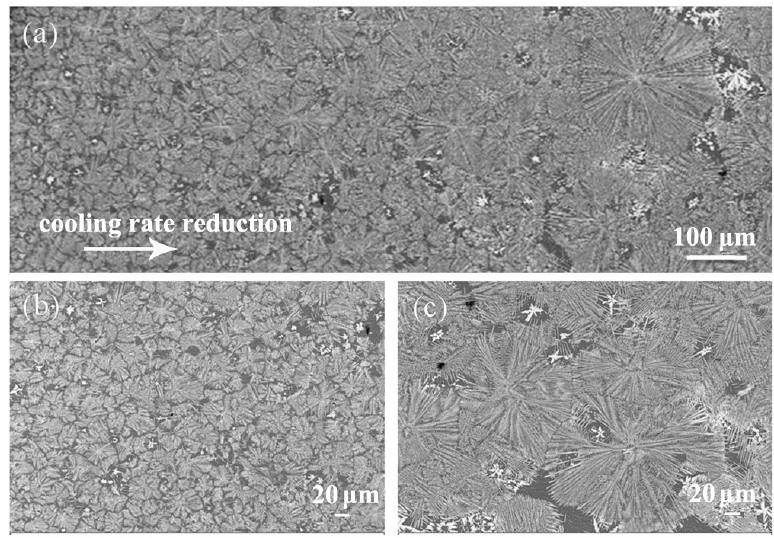
Figure 10. SEM BSE of the cross-section of the cylindrical sample in suction casting Al–10 wt.% Mn alloy: ( a ) full sample; ( b ) at the edge of the sample; ( c ) at the center of the sample.